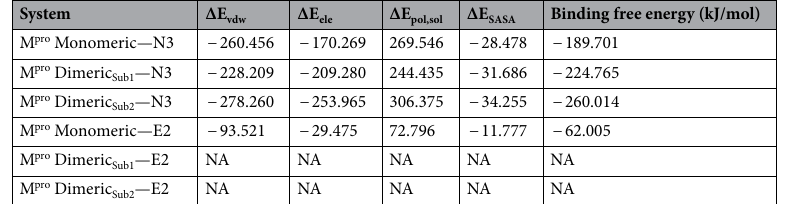
System ΔE vdw ΔE ele ΔE pol,sol ΔE SASA Binding free energy